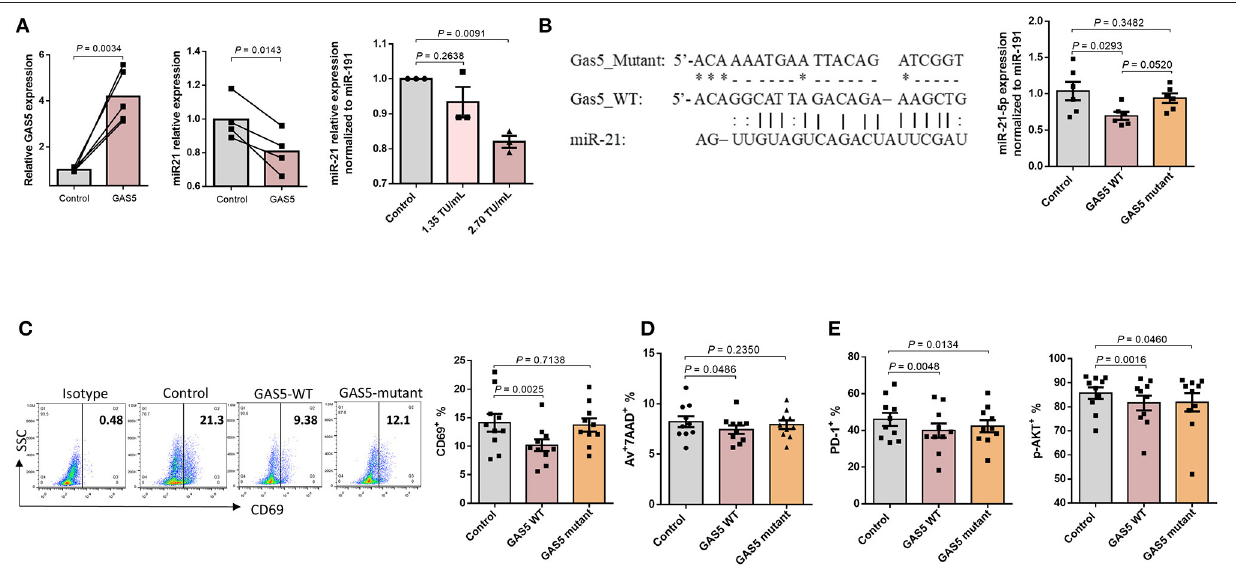
FIGURE 5 | GAS5 controls CD4T cell response and apoptosis beyond miR-21-mediated signaling pathways. (A) Relative expressions of GAS5 ( n = 5) and miR-21 ( n = 4) in CD4T cells from PLHIV, following overexpression of GAS5, determined by RT-qPCR. (B) Left panel, sequences of GAS5-mutant and GAS5-WT constructs, and the corresponding miR-21 binding site. Right panel, relative miR-21 expression in CD4T cells from PLHIV transfected with control, GAS5-WT, or GAS5-mutant constructs ( n = 6). (C–E) Expression of T cell activation, apoptosis, and exhaustion markers in CD4T cells from PLHIV transfected with control, GAS5-WT, or GAS5-mutant construct, determined by flow cytometry ( n =